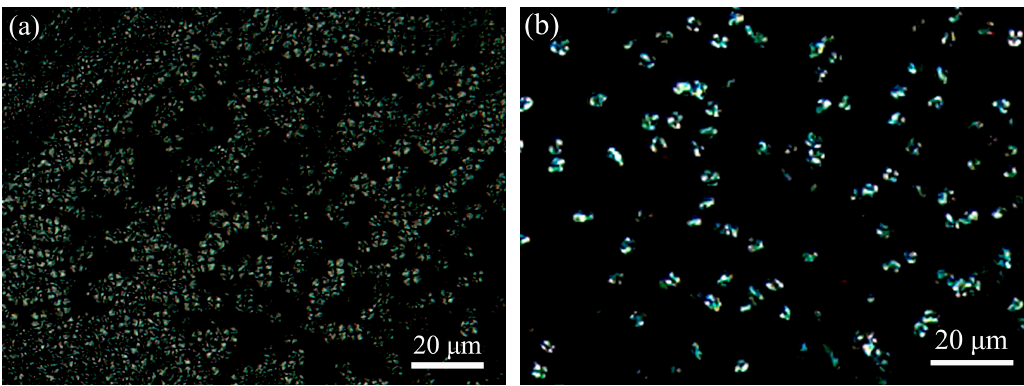
Figure 9. Polarized optical microscopic (POM) observations of the crystal morphologies: ( a ) PI-1 crystallized at 280 °C for 5 min; ( b ) PI-2 crystallized at 300 °C for 5 min.